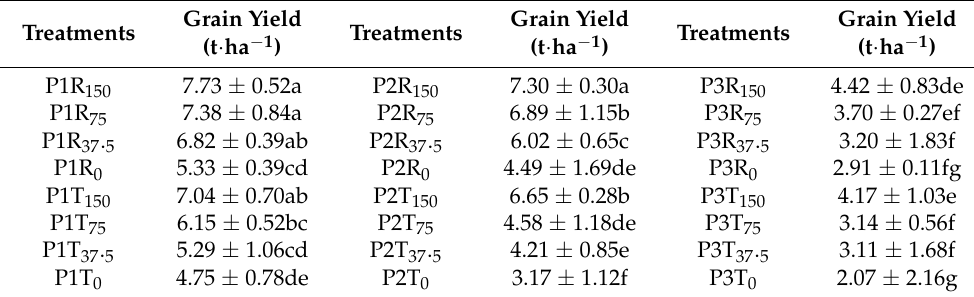
Table 1. Effects of planting models and limited irrigation on grain